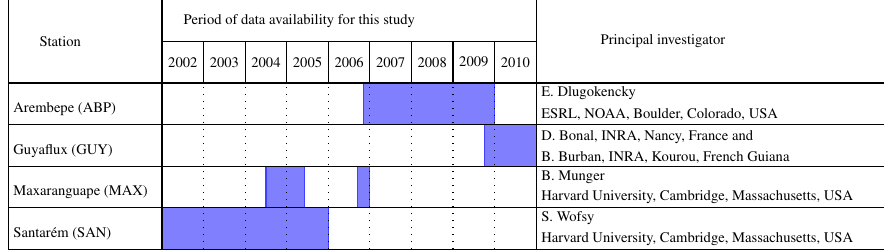
worth analysing. This also suggests that the inversions yield a large uncertainty reduction for